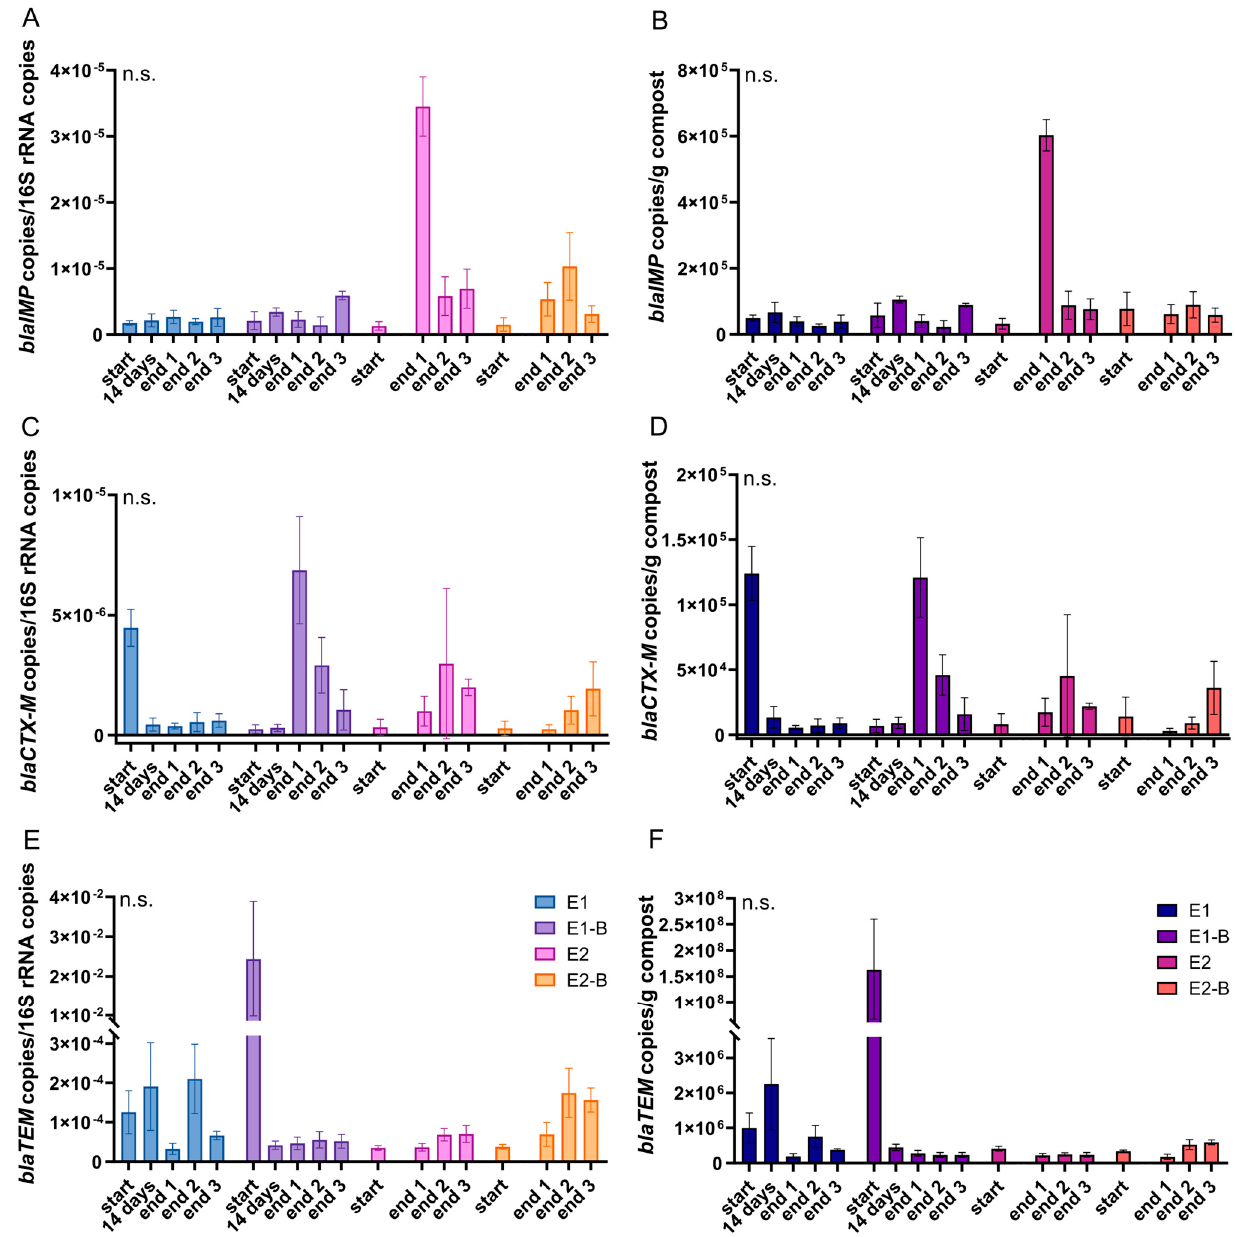
Figure 1. Copy numbers of beta-lactam ARGs bla IMP ( A , B ) and bla CTX-M ( C , D ), as well as bla TEM ( E , F ) as assessed by qPCR. Copy numbers were normalized to 16S rRNA gene copy numbers (left charts) and to 1 g compost (right charts). Bars represent the average of three individual qPCR measure- ments with standard deviation. Start samples, 14-days samples (only repetition 1) and end samples are depicted individually for the first (E1, E1-B) and second repetition of composting (E2, E2-B). End samples comprise replicates from front (end 1), middle (end 2) and back (end 3) of each compost pile. The p -values were calculated to compare start with end samples of composting for all four compost piles combined (average of the triplicate end samples, no differentiation of the treatments). None of the sample sets showed significance ( p < 0.05). Therefore, they are indicated by “n.s.” (not significant).